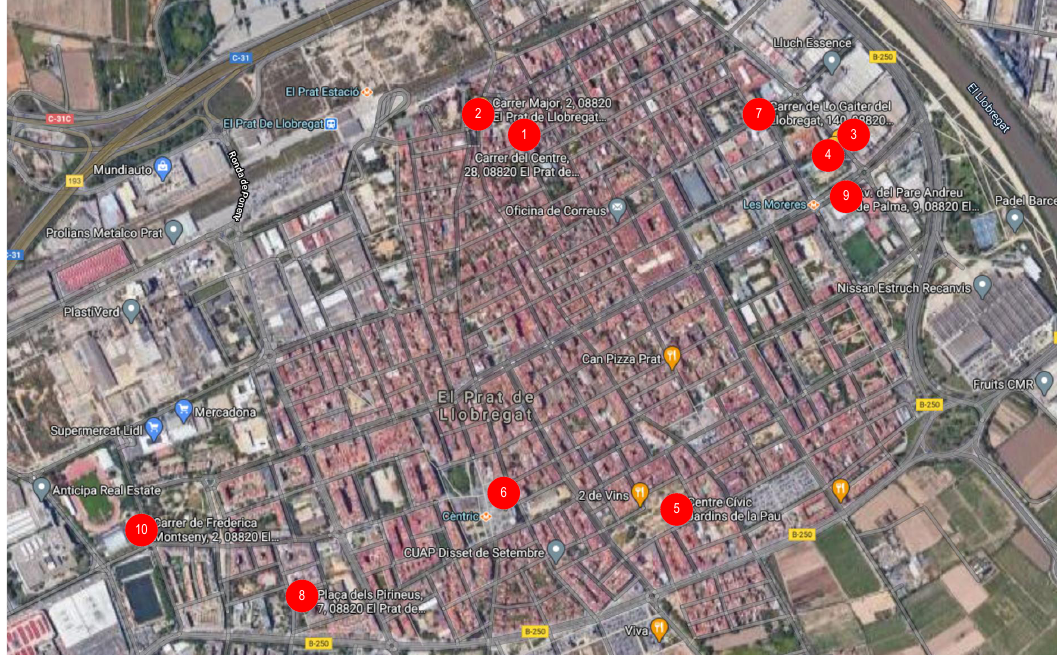
Figure A2. An aerial view of “El Prat del Llobergat” highlighting the locations of the 10 different buildings of the Barcelona demonstration